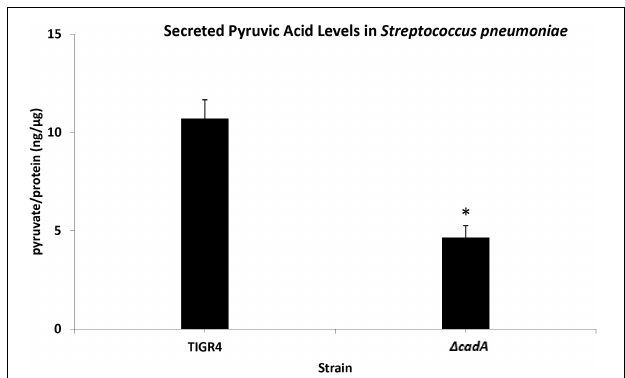
FIGURE 6 | Measurement of secreted pyruvic acid from Spn TIGR4 and (cid:49) cadA . Secreted pyruvate in a putative lysine decarboxylase deficient (cid:49) cadA strain and Spn TIGR4 was measured using Pyruvic Acid Assay Kit (Megazyme, Bray, Ireland) according to the manufacturer’s protocol. Results show that secreted pyruvate levels in (cid:49) cadA were ∼ 60% lower compared to the wild type strain. This data suggest that the glycolytic pathway is impaired in the polyamine synthesis deficient pneumococci. ∗ indicate significance at P ≤